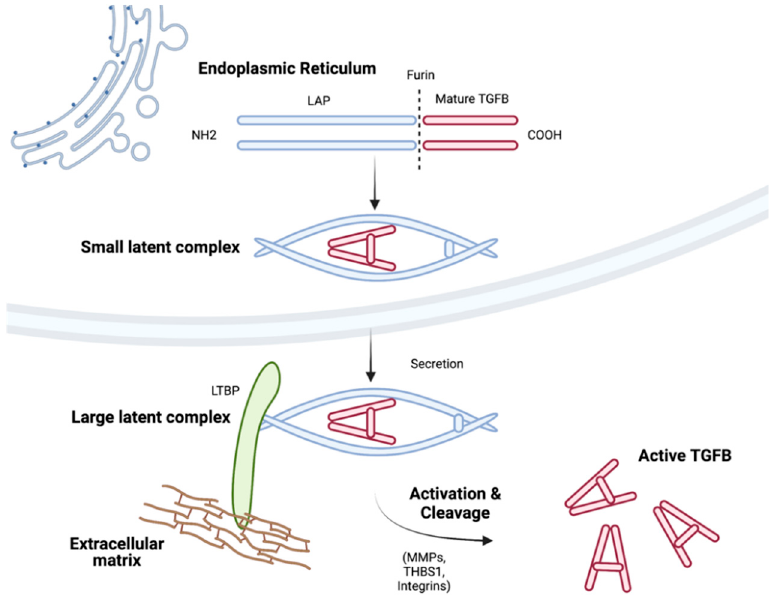
Figure 2. Processing of TGFB isoforms. TGFB genes encode a C-terminal mature cytokine and an N-terminal latency-associated protein (LAP) that form a dimeric structure. LAP and mature TGFB cytokine are cleaved by the enzyme furin but remain non-covalently associated with LAP folding around the mature cytokine forming the small latent complex. The small latent complex can associate with latent TGFB binding protein (LTBP) via LAP forming the large latent complex facilitating binding to the extracellular matrix. For active signalling TGFB must be released from latent complexes mediated through interactions with MMPs, THBS1, and integrins [4]. Figure generated using Biorender.com (accessed 28 February 2022).